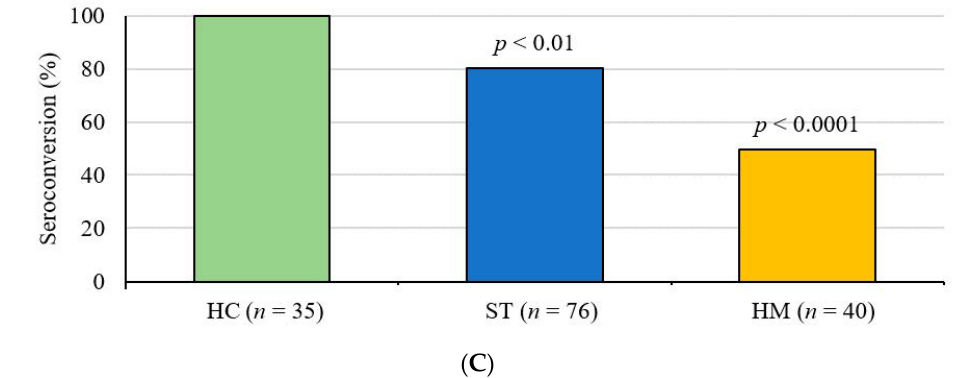
Figure 1. ( A ) Anti-spike Antibody Concentrations in Healthy Controls and Cancer Patients Following Two Doses of SARS-CoV-2 Vaccine. ( B ) Anti-spike Antibody Levels in Cancer Patients On and Off Treatment. ( C ) Frequency of Seroconversion Rate in Healthy Patients and Cancer Patients According to 35.2 BAU/mL cutoff. p -values as determined by ( A ) Tukey test against healthy controls, ( B ) Tukey test against off treatment group, and ( C ) Chi-square test against healthy controls. HC: healthy controls; ST: solid tumor; HM: hematological malignancy.